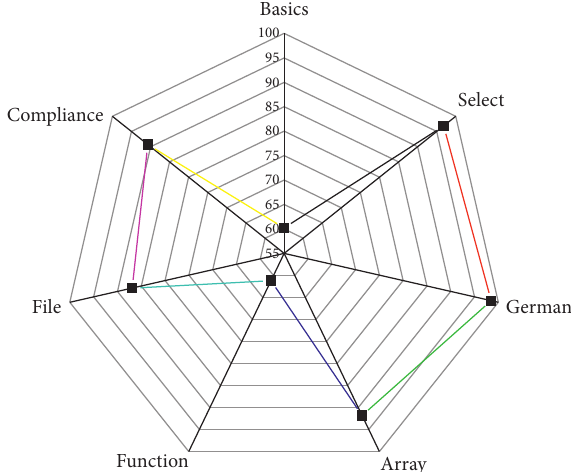
Figure 9: Level 3 Teaching Overview Page.